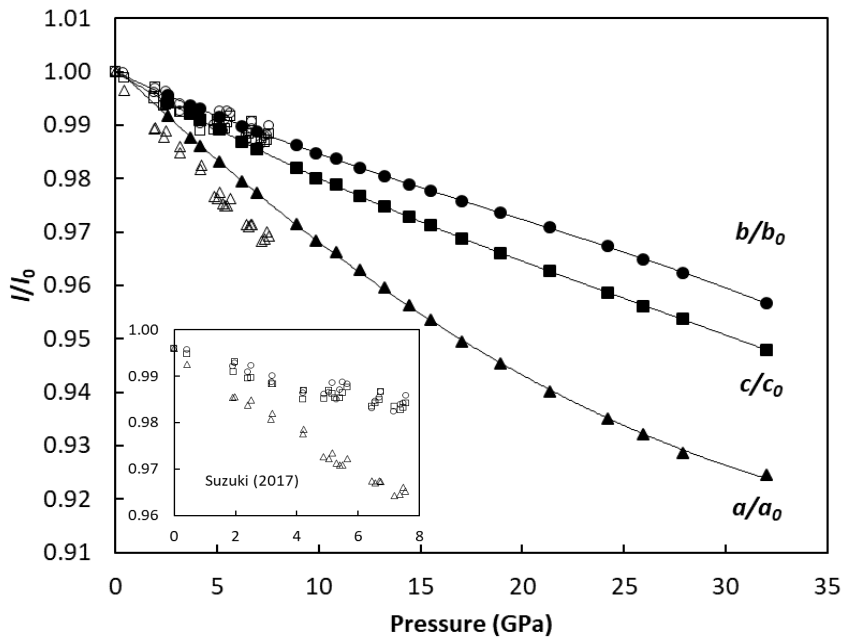
Figure 10. Normalized unit-cell parameters of goethite as a function of pressure with a 0 = 4.602 Å, b 0 = 9.961 Å, and c 0 = 3.026 Å. Open symbols are from Suzuki [16].